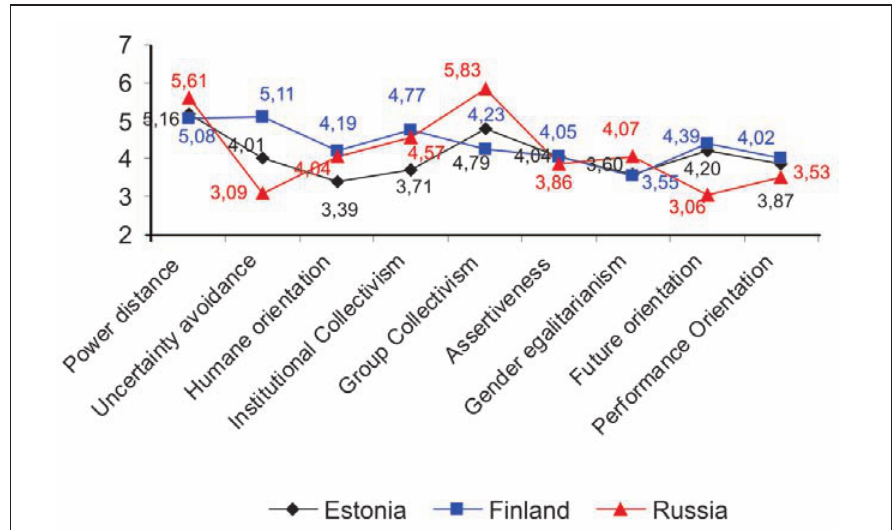
Fig 1 . Comparison of societal practices in three countries